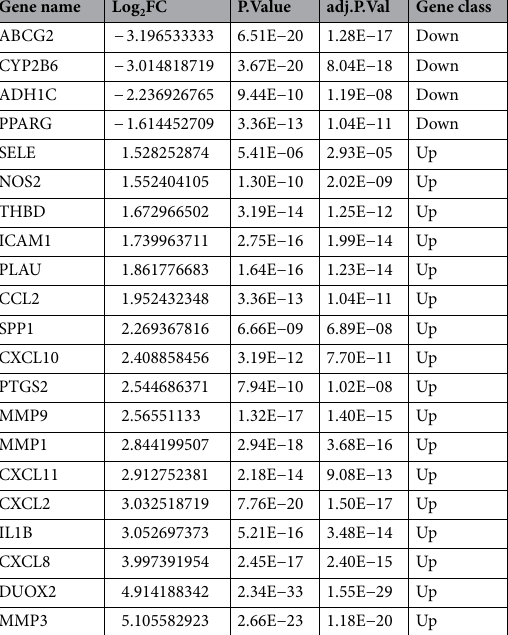
Table 1. The identified 21 upregulated and downregulated DEGs between UC tissue samples and normal tissue